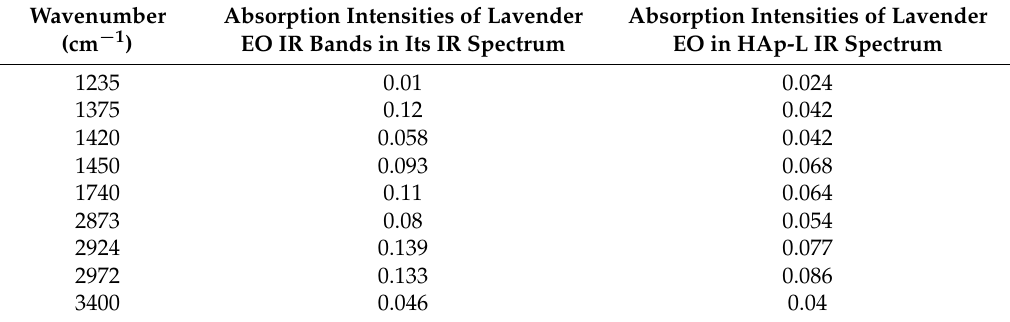
Table 3. Absorption intensities of lavender EO IR bands in lavender EO and HAp-L IR spectra.